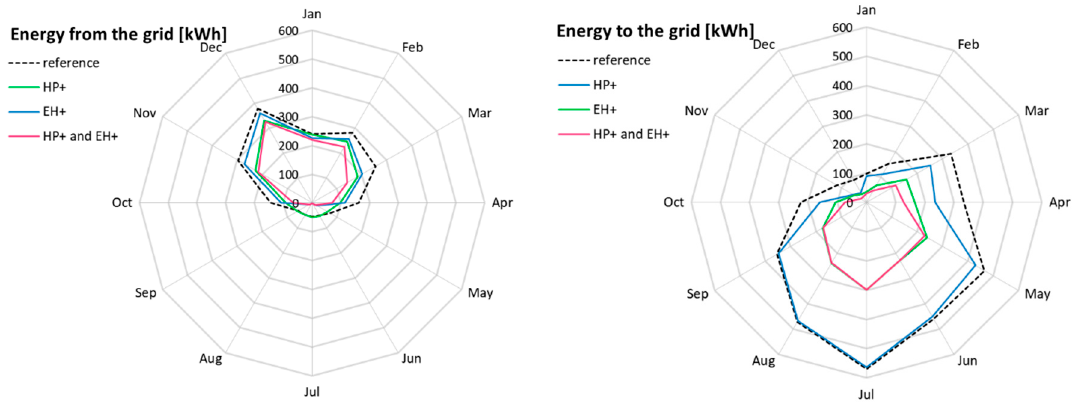
Figure 4. Monthly energy exchanges with the grid for the reference case, and for the cases with the new control algorithms (PV area of 20 m 2 ).